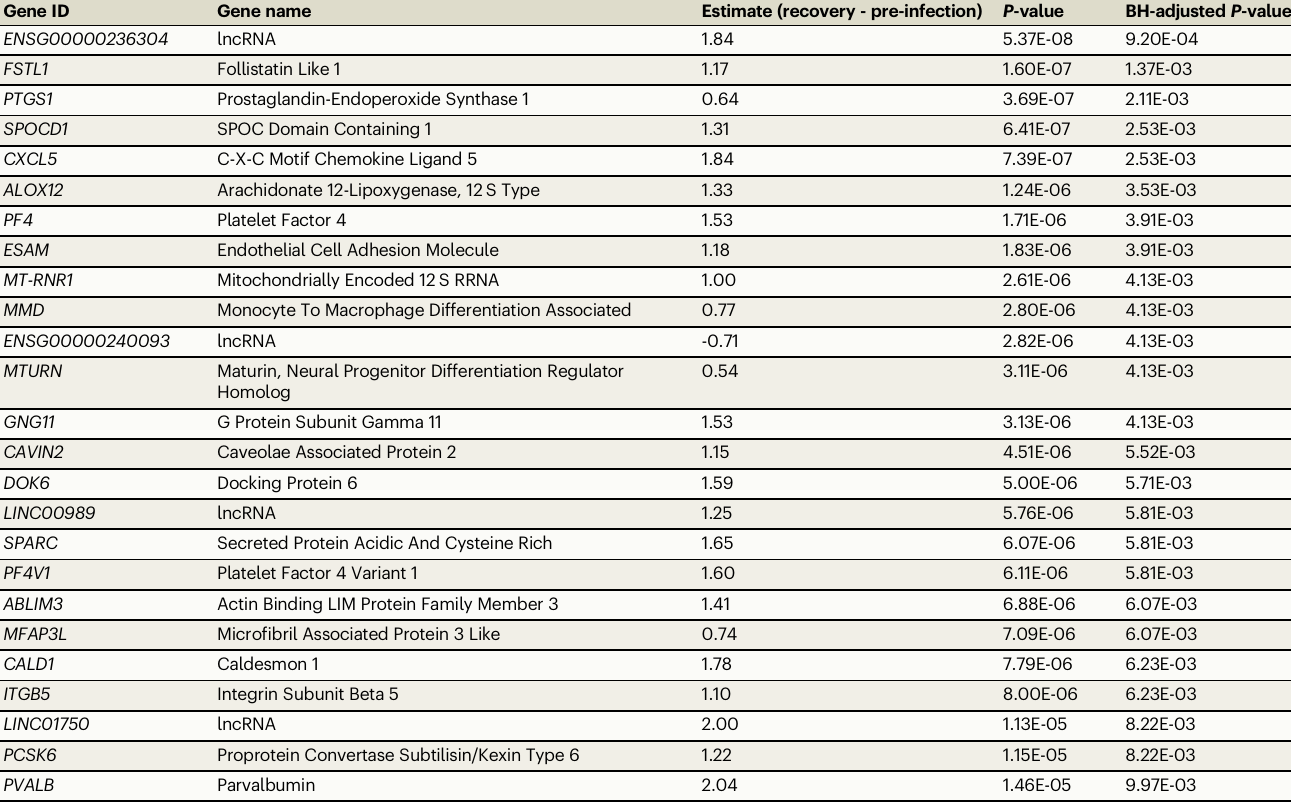
Table 1 | Genes that do not return to baseline 2 months after recovery from